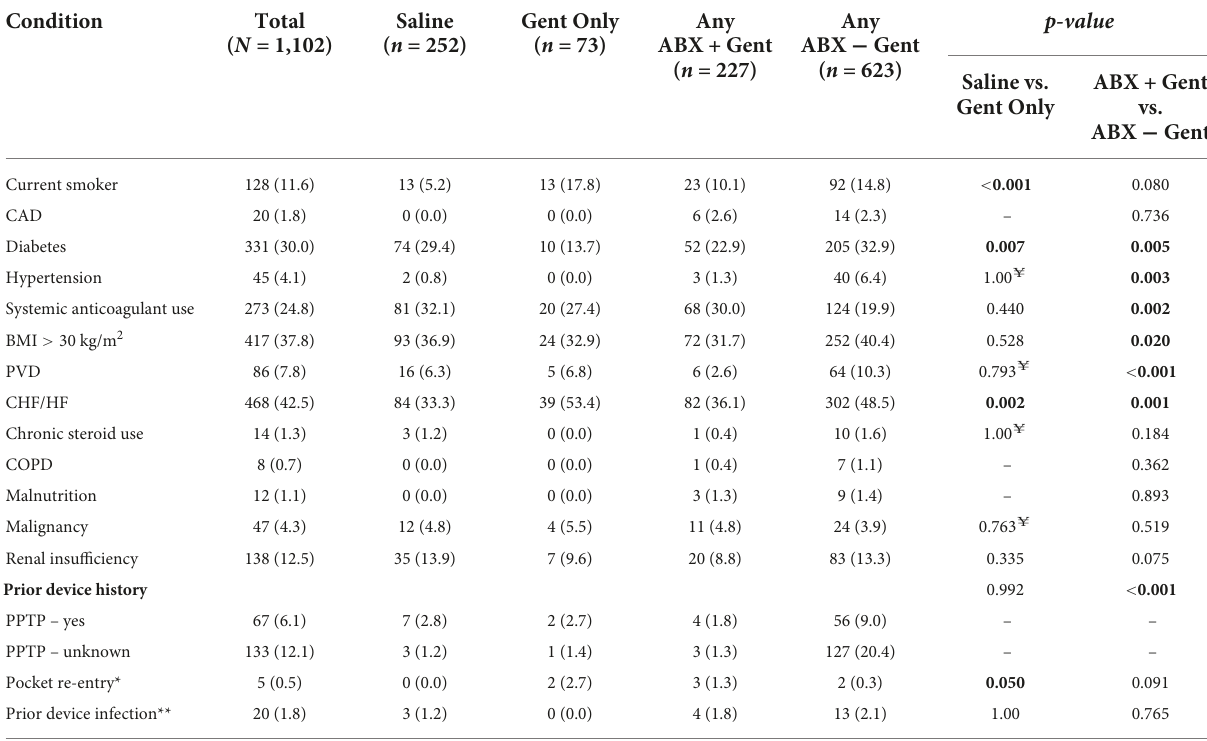
TABLE 2 Patient medical